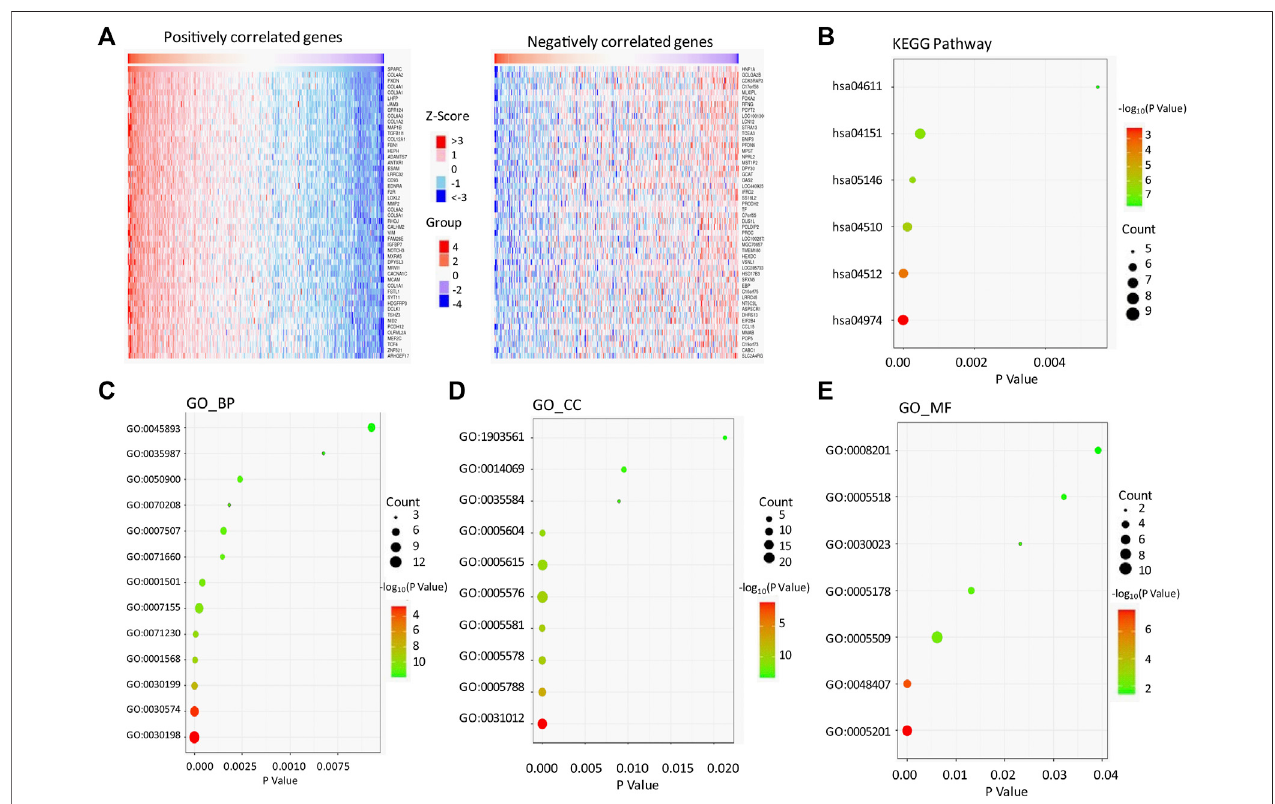
FIGURE 4 | SPARC-associated genes and pathway enrichment in LIHC. (A) Heatmaps showing top 50 genes positively correlated (left) and top 50 genes negatively correlated with SPARC in LIHC (right) . (B) Enriched KEGG pathways of SPARC-associated genes. (C – E) Enriched GO terms of SPARC-associated genes.